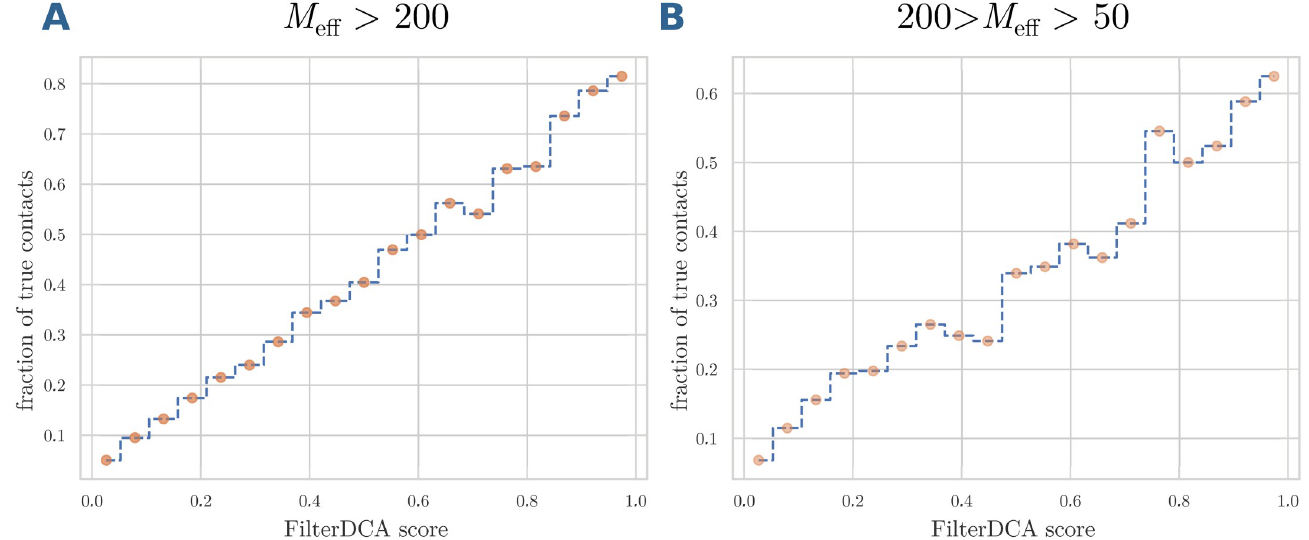
Fig 8. Fraction of true residue as a function of the FilterDCA score. The fraction of true contacts is evaluated in the test sets for large (panel A) and medium (panel B) MSA sizes, as a function of the predicted contact probability P ( � | x ) provided by FilterDCA (filter size 45 × 45). We observe a clear linear relationship, with a slope slightly below one due to overfitting effects resulting from the finite training set and the limited complexity of our regression